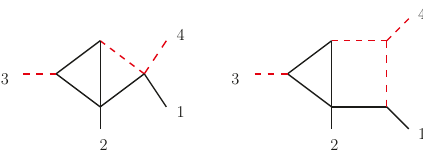
Figure 6. New master integral topologies appearing in the amplitude with a closed top-quark loop A (2) ,N h . Black-solid lines represent massive particles, red-dashed lines represent massless particles.